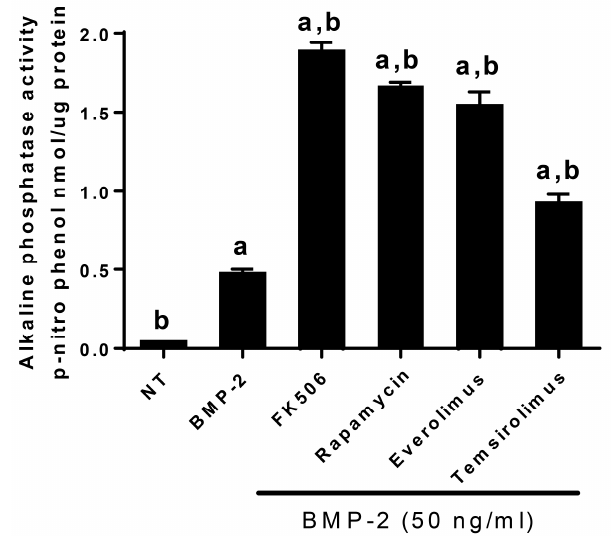
Figure 2. Enhancement of BMP-2-induced ALP enzyme activity by a family of macrolides (FK506, rapamycin, everolimus, and temsirolimus) that were computationally predicted to interact with BMP receptor type I (BMPRI), displace FKBP12, and potentially enhance BMP signaling. FK506 exhibited the strongest ability of the macrolide family to enhance BMP-2-induced alkaline phosphatase activity after 72 h of treatment. Data points of luciferase activities were determined in triplicate ( n = 3). The labelings of a (BMP-2 alone control) and b (no treatment control) denote statistical significance ( p < 0.05), determined as described in “Materials and Methods,” between the indicated treatments.